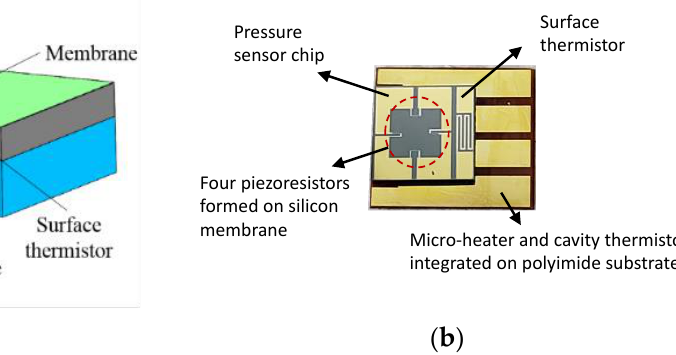
Figure 5. ( a ) Cross-section view of the sensing element inside the self-calibrating pressure sensor and ( b ) a microscopic image of such a sensor chip, note that the red circle indicates the sensing region with four piezoresistors built on the membrane [31].